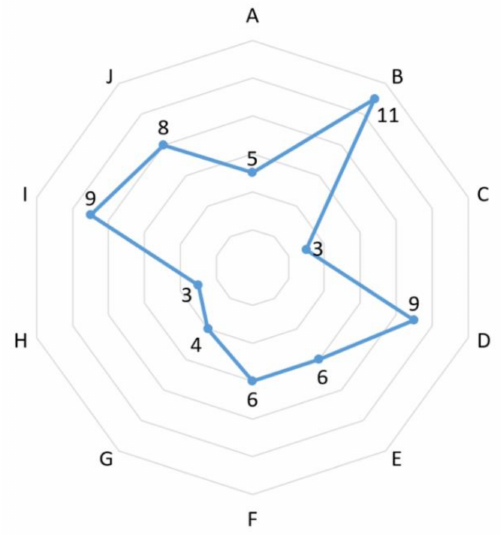
Figure 2. Benefits of mobile learning, A : Constructivist Learning; B : Student behavior; C : Learning spaces; D : Collaborative Learning; E : Informal and self-directed learning; F : Resources for teach- ers; G : Technology and support; H : Affordability and portability; I : Availability and flexibility; J : Motivational